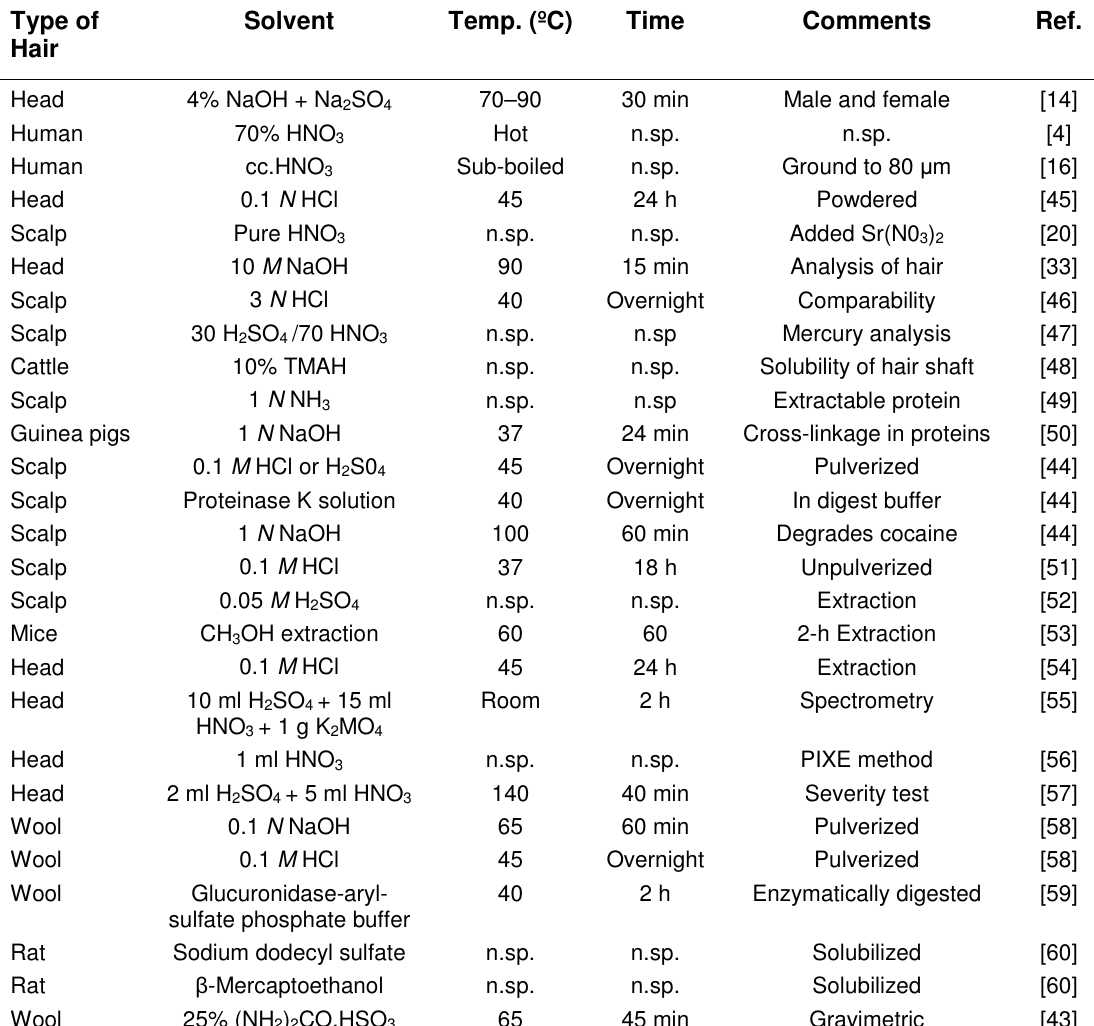
Solubility/Digestion of Hair in